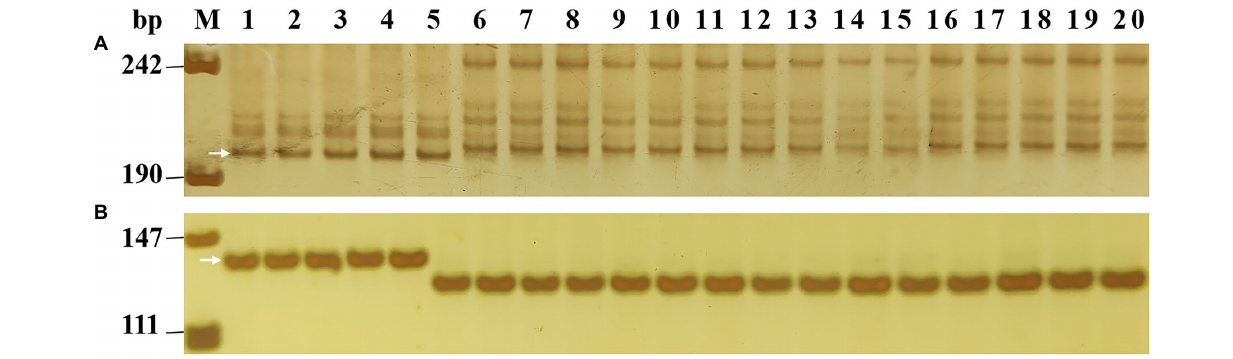
FIGURE 4 | Amplification patterns of Pm2 linked marker Cfd81 (A) and diagnostic marker Pm2b-map-3 (B) in five Pm2 donors and 15 susceptible wheat cultivars/ breeding lines. M, DNA marker pUC18 Msp I; lanes 1–5, five Pm2 donors with sequential order of Lande 677, LS4695, NZ8, NZ13, and GQ16031; lanes 6–20, wheat cultivars/breeding lines with sequential order of Shimai 22, Taimai 1918, Hanmai 13, Tainong 18, Shannong 15,381, Taitianmai 118, Zhongxin 7503, Jimai 61, Huixianhong, Yannong 21, Shixin 633, Mingxian 169, Xinshiji 156, 12CA49, and Shi 6609. The white arrows indicate the polymorphic bands in Pm2